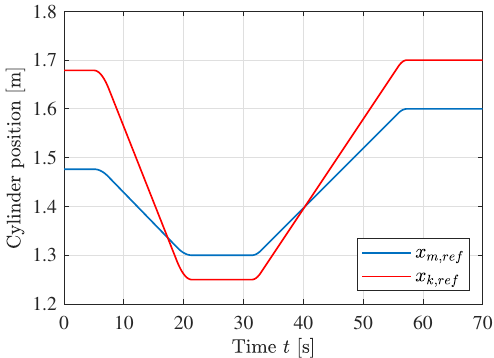
Figure 28. Cylinder position reference during load case.